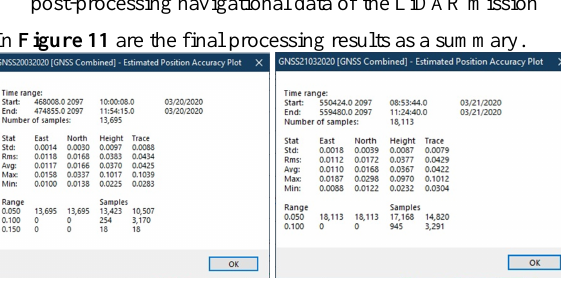
Figure 11 . Estimated Position Accuracy of the LiDAR missions (left - flight from 20.03.2020, right - flight from 21.03.2020)